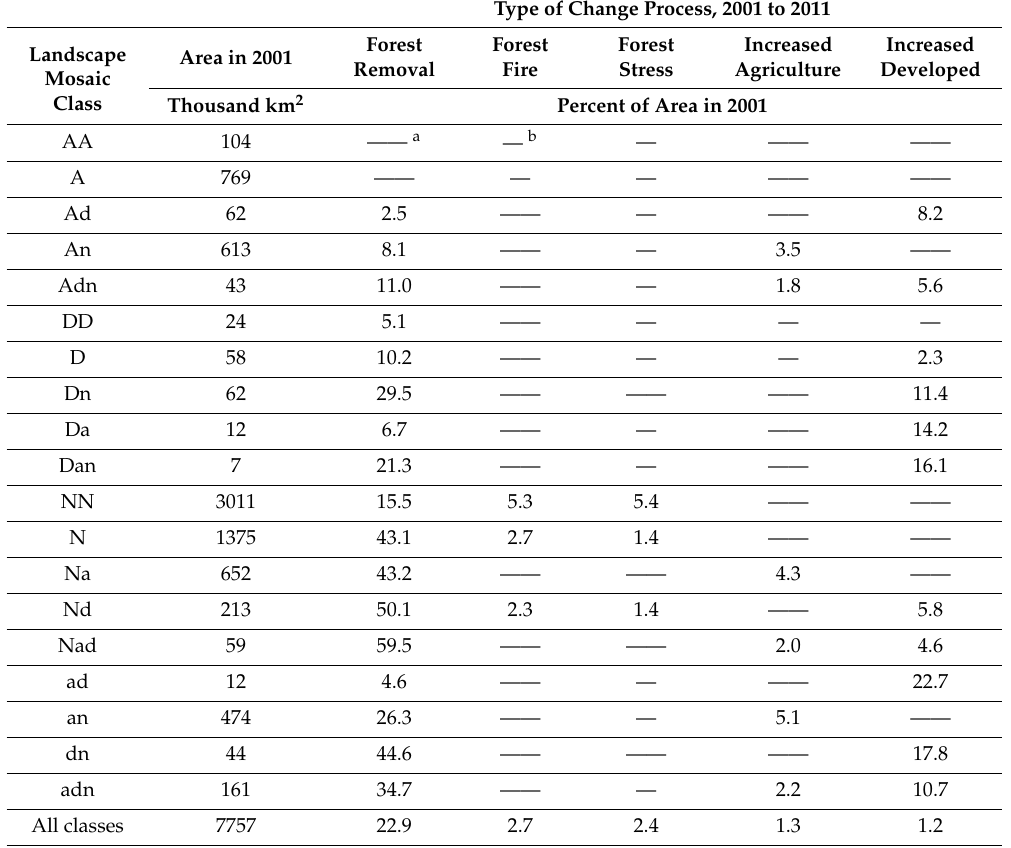
a “——” indicates < 1, b “—” indicates <